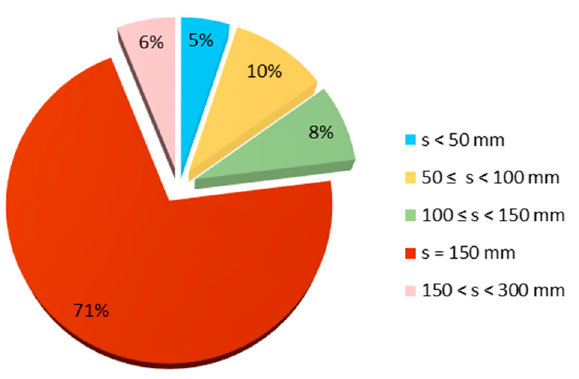
Figure 11. Cavity thickness incidence. Note: For cavity > 300 mm, the thickness incidence is 0%.